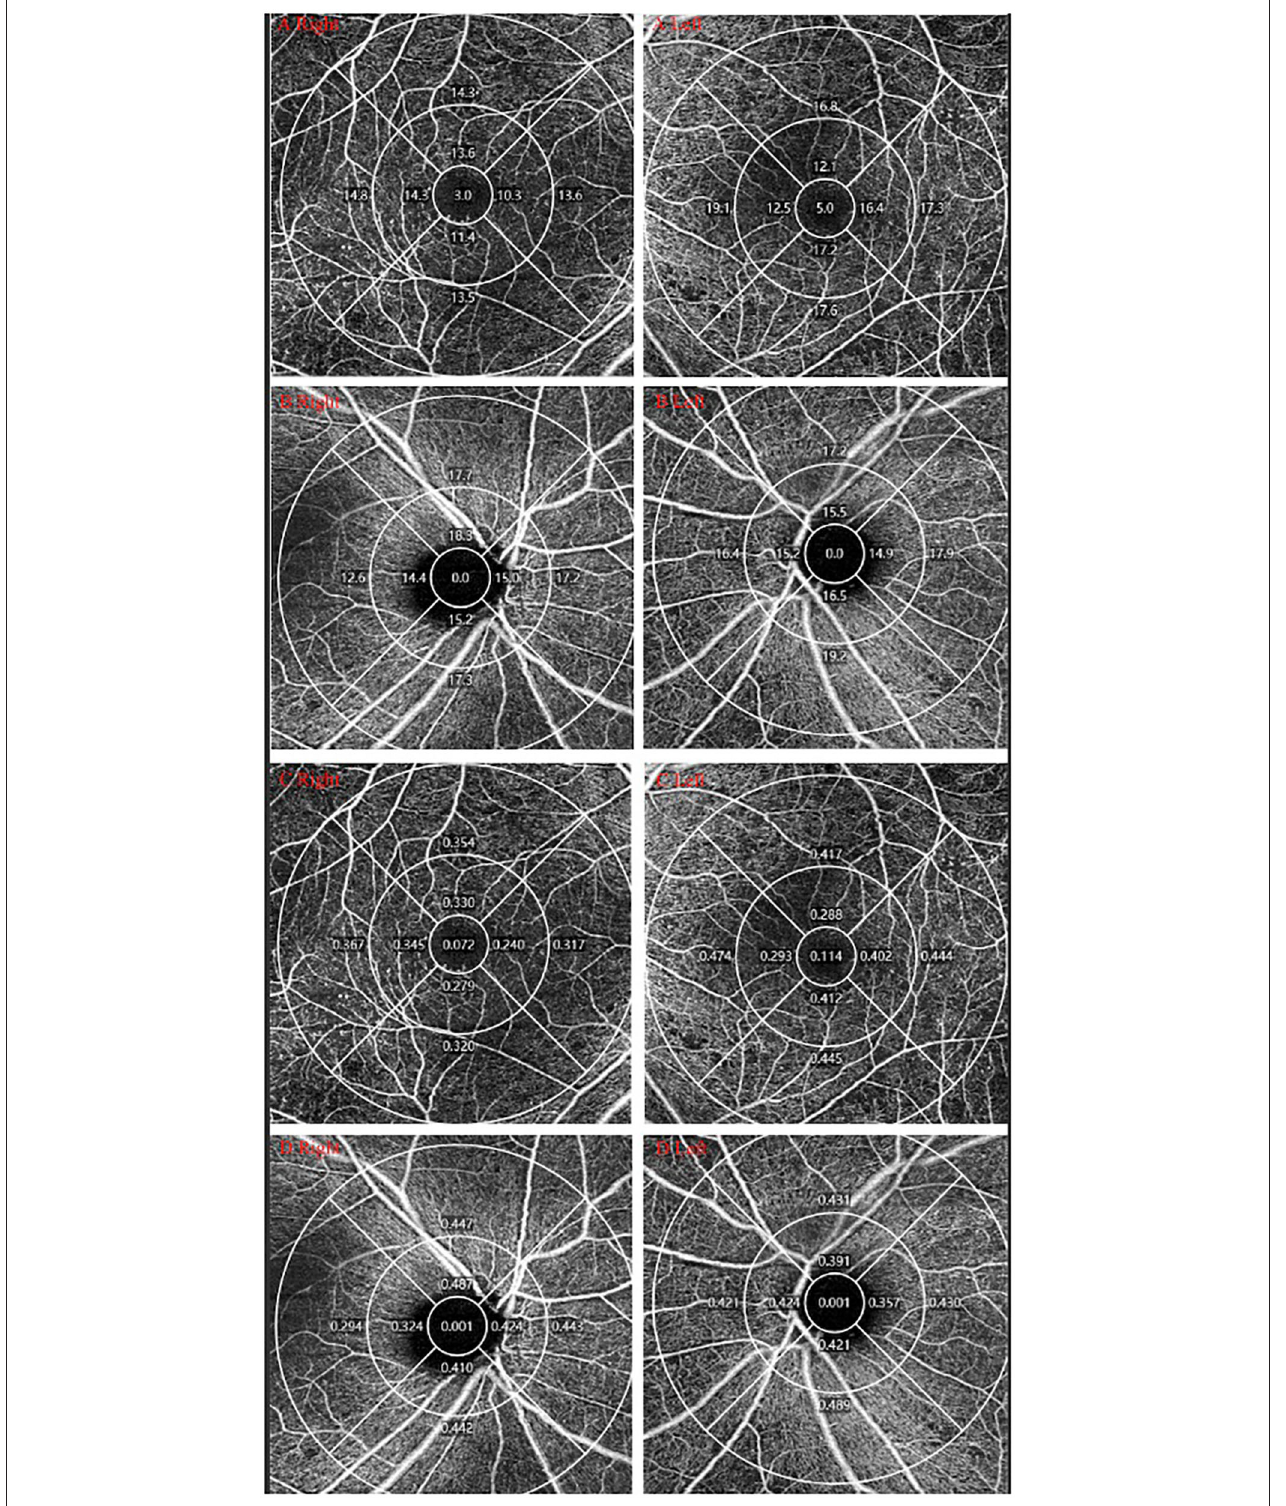
FIGURE 2 | OCTA measurement of DR. One DM patients was diagnosed with PDR in the right eye and NPDR in the left eye. (A,B) VD of macular/peripapillary area in both eyes; (C,D) PD of macular/peripapillary area in both eyes.